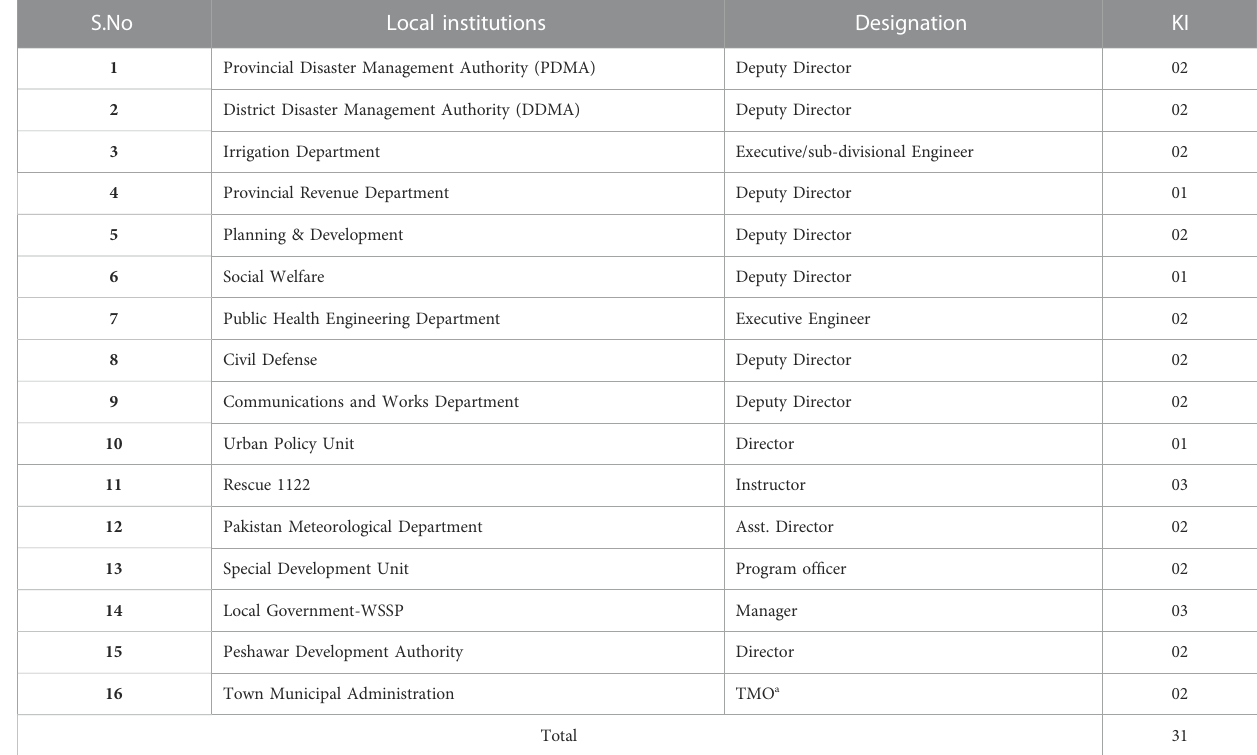
TABLE 1 Characteristics of local experts consulted for key informant interviews in Khyber Pakhtunkhwa, Pakistan.